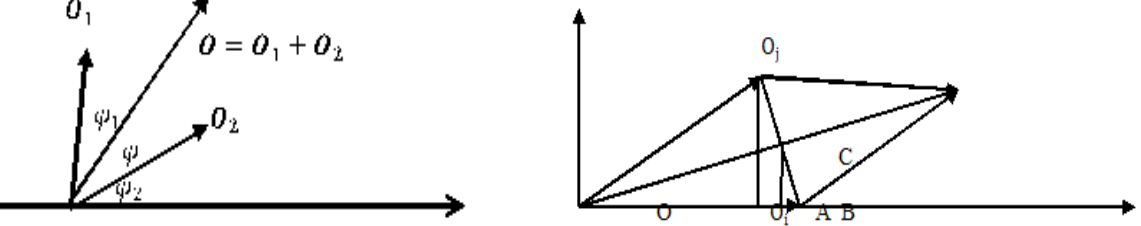
Figure 1. Opinion vectors. Left frame, general view. Right frame, total opinion is rotated so the militant opinion is aligned parallel to the exterior